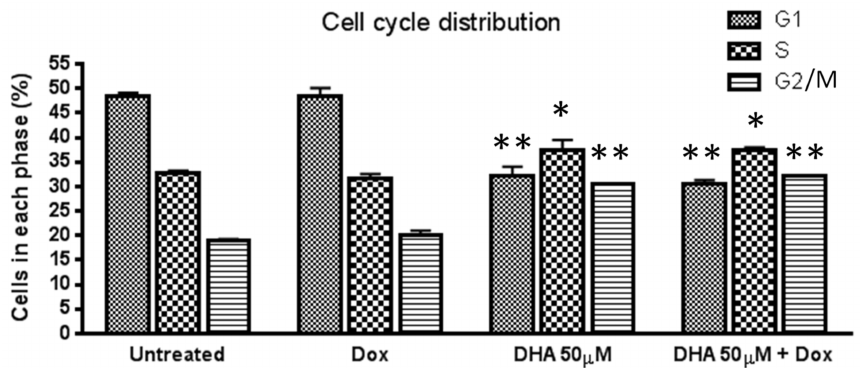
Figure 3. Effect of DHA co-treatment on cell cycle arrest in MCF-7/Dox cells. MCF-7/Dox cells were treated with either DHA, Dox, or a combination of both for 24 h, followed by isolation, treatment with ethanol, staining with propidium iodide, and FACS analysis to determine cell cycle distribution. The reported values represent the average ± standard error of the mean from three independent experiments. A p -value of <0.05 is considered significant by a Newman–Keuls one-way ANOVA with multiple comparisons test. * p < 0.05, ** p < 0.01 compared to respective untreated control. G1, Gap 1 phase for cell growth; S, synthesis phase for DNA synthesis; G2, Gap 2 phase for cell growth; M, mitosis phase for cell multiplication.